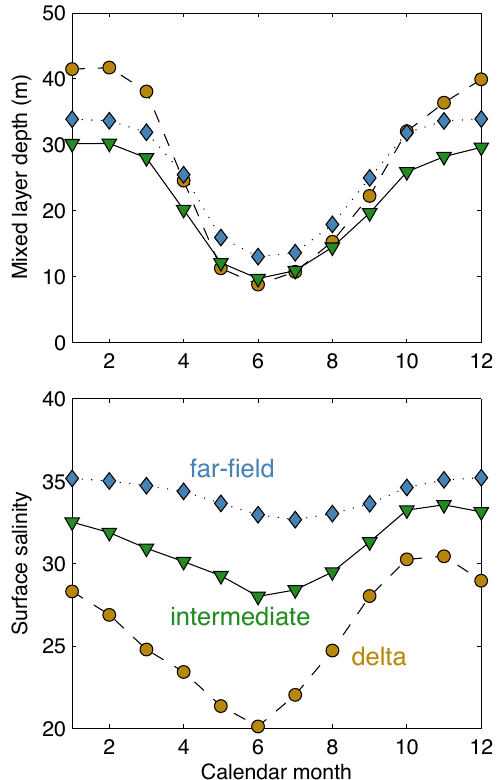
Fig. 12. Climatological monthly means of simulated mixed layer nitrate (top), phytoplankton (middle) and zooplankton (bottom) biomasses for the delta, intermediate and far-field regions (see Fig.